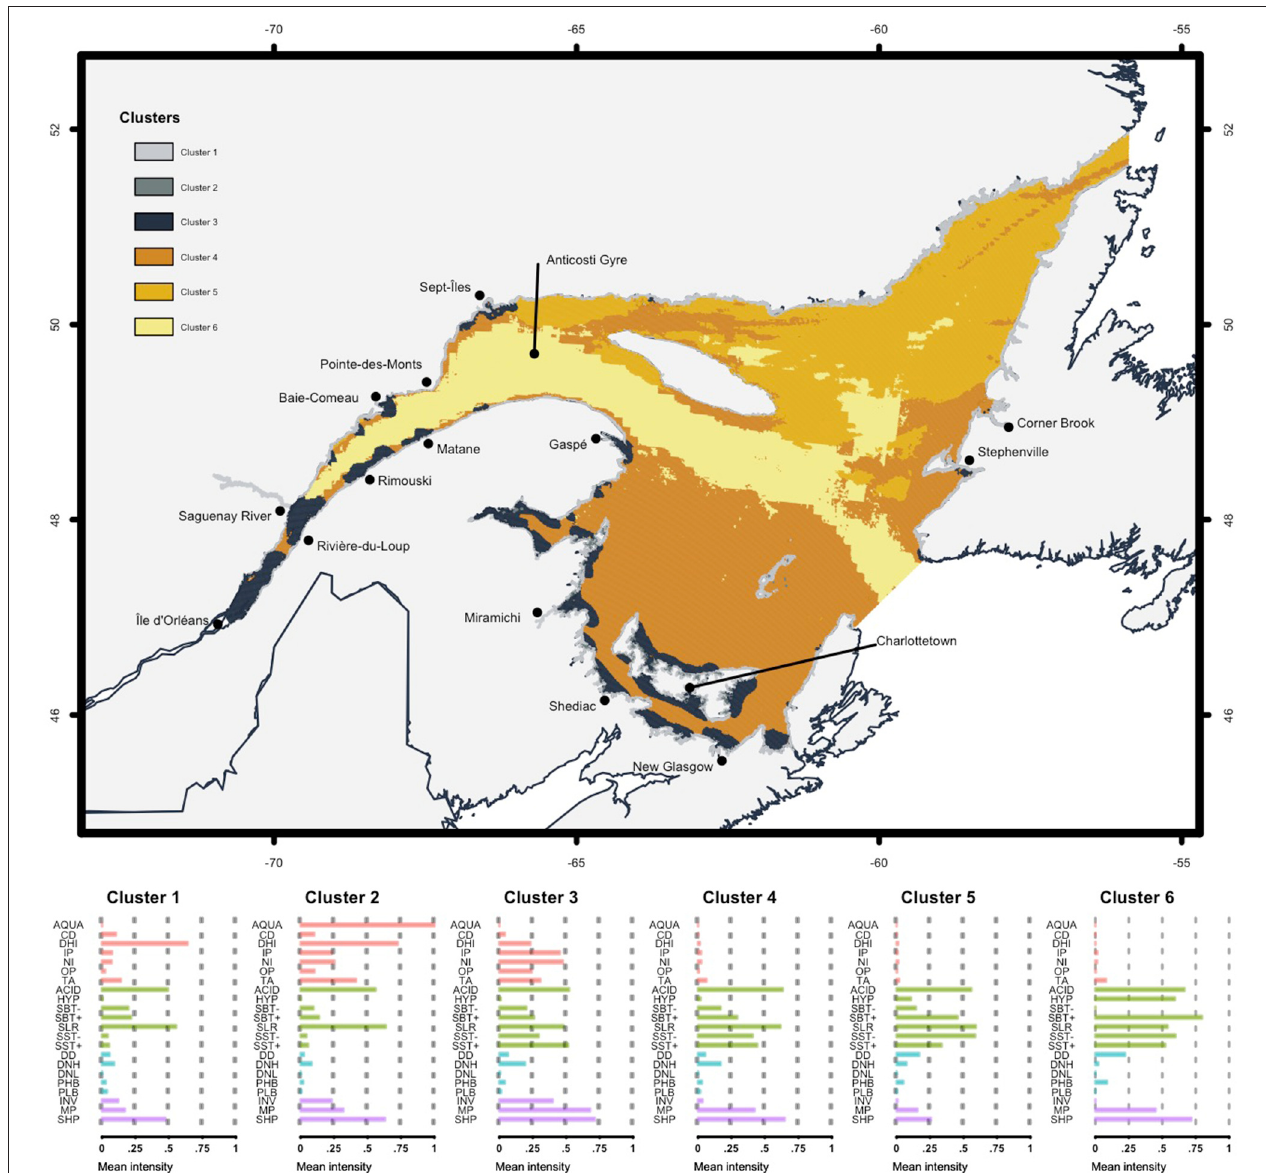
FIGURE 5 | Distribution of areas with similar cumulative exposure profiles in the Estuary and Gulf of St. Lawrence, identified through a clustering approach (Top) . Mean intensity of all coastal (red), climate (green), fisheries (blue), and marine traffic (purple) drivers within each cluster (Bottom) . Refer to Table 1 for acronym meaning and to the Supplementary Materials for more